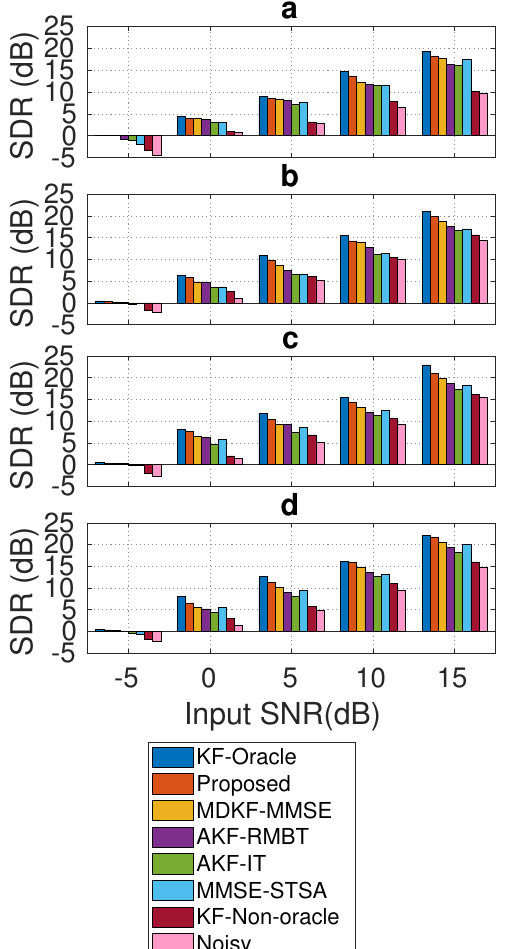
Figure 9. Average SDR (dB) score comparison between the proposed and benchmark SEAs on NOIZEUS corpus corrupted with: ( a ) babble , ( b ) street , ( c ) factory2 , and ( d ) f16 noises for a wide range of SNR levels (from − 5 to 15